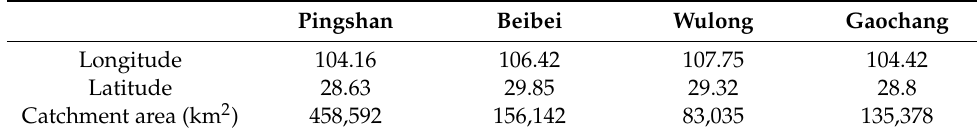
Table 1. The information of five control gauges.